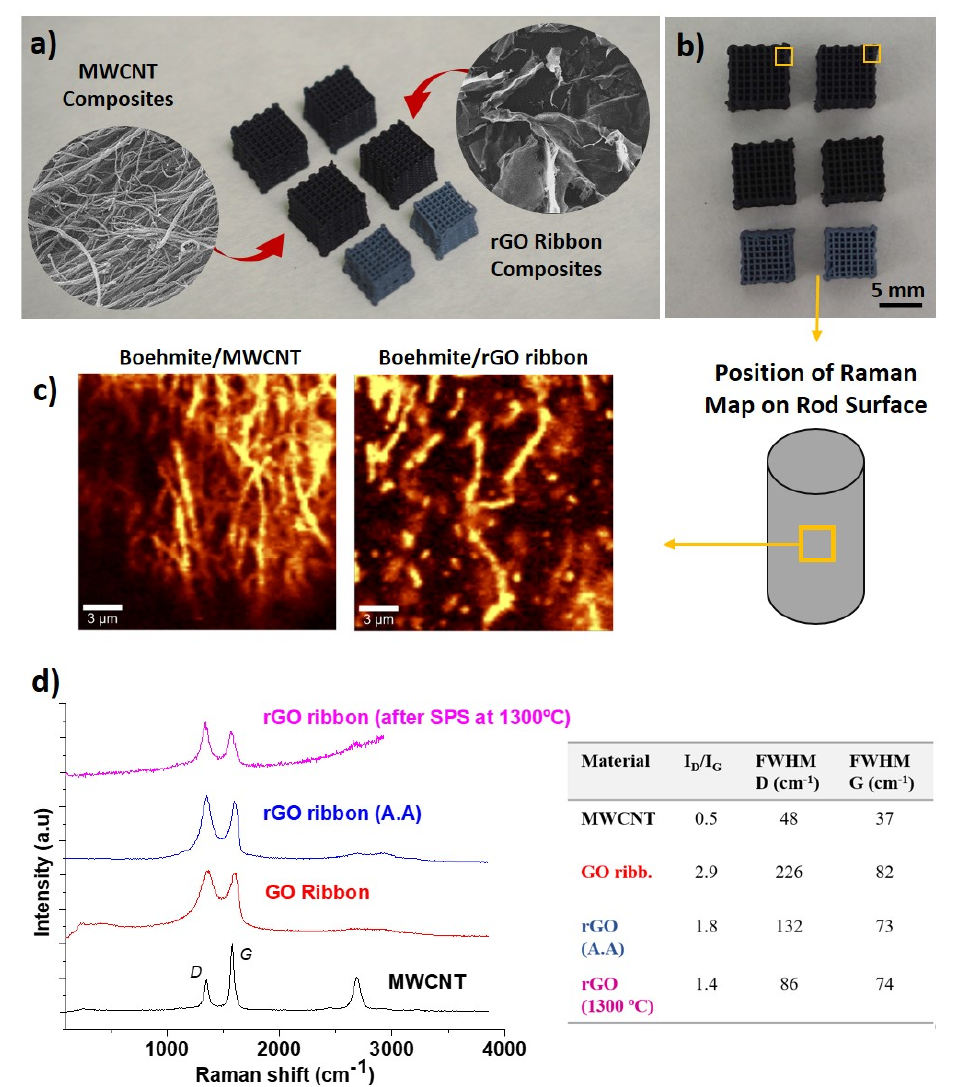
Figure 3. ( a , b ) Images of the composite scaffolds, arranged from top to bottom as follows: boehmite/MWCNT and boehmite/rGO ribbon; γ -Al 2 O 3 /MWCNT and γ -Al 2 O 3 /rGO ribbon; α -Al 2 O 3 /MWCNT and α -Al 2 O 3 /rGO ribbon. FESEM images of carbon nanostructures are inserted in ( a ). ( c ) Raman maps representing intensity of the carbon nanostructure’s G peak in an area of rod surface of boehmite/MWCNT and boehmite/rGO ribbon. ( d ) Raman spectra of rGO ribbons at different stages of synthesis and composite structures treatment. rGO (A.A) corresponds to the ascorbic-acid-treated GO ribbons. The table includes I D /I G, the ratio of integrated areas of D and G peaks, and the full width at half maximum (FWHM) of the bands.